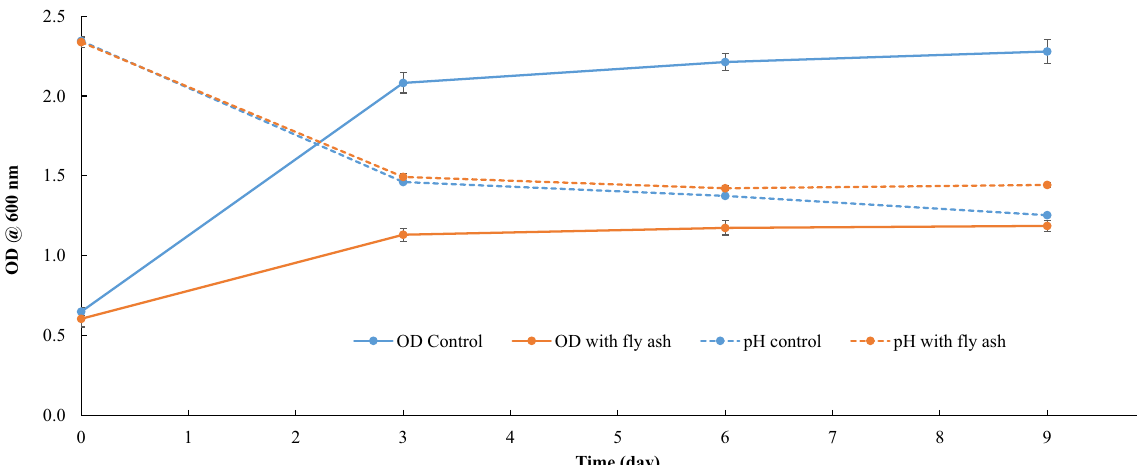
Fig. 6 Candida bombicola growth and pH change with time